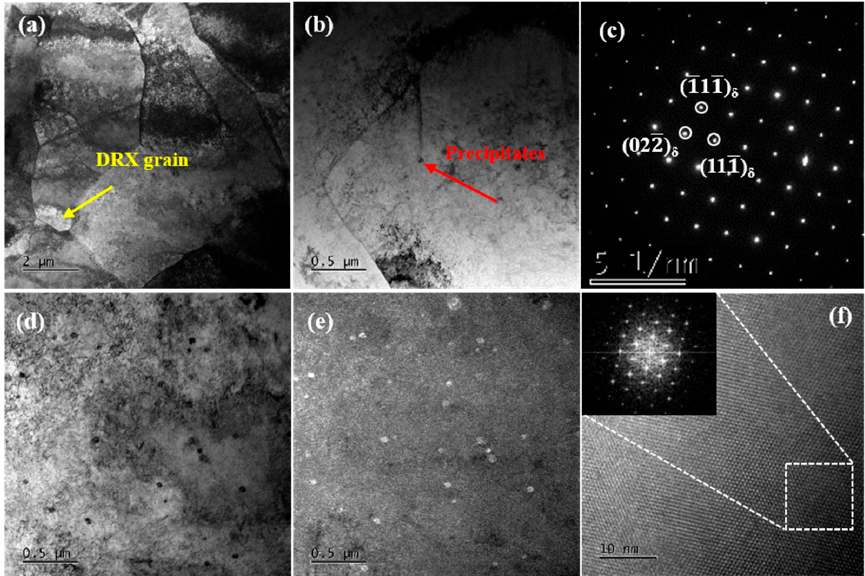
Figure 5. TEM and HRTEM images of the new type of Cu-1.1–Ni-0.7–Co-0.45–Si-0.3Cr alloy deformed at 800 °C and 0.01 s − 1 . ( a , b ) Bright-field TEM image, ( c ) SAED analysis of precipitates in B, ( d ) bright-field TEM image, ( e ) dark-field TEM image of ( d ), ( f ) HRTEM image and corresponding FFT pattern of a (Ni, Co) 2 Si particle.